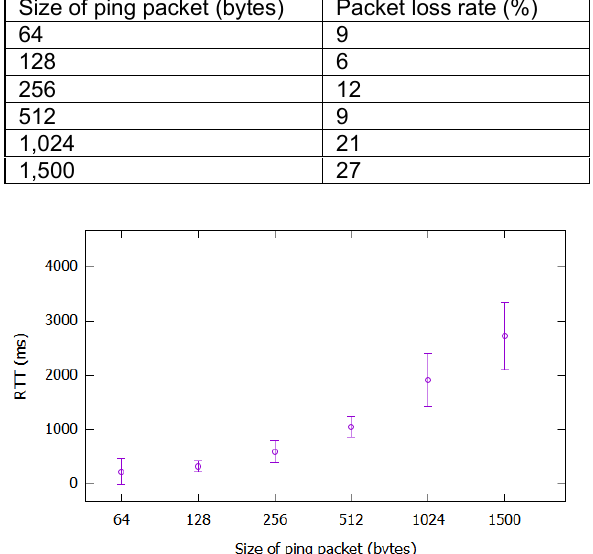
Figure 7. Comparison of average round trip time (error bars representing standard deviation) according to the size of the ethernet frame in the range of 64 bytes to 1,514 bytes.